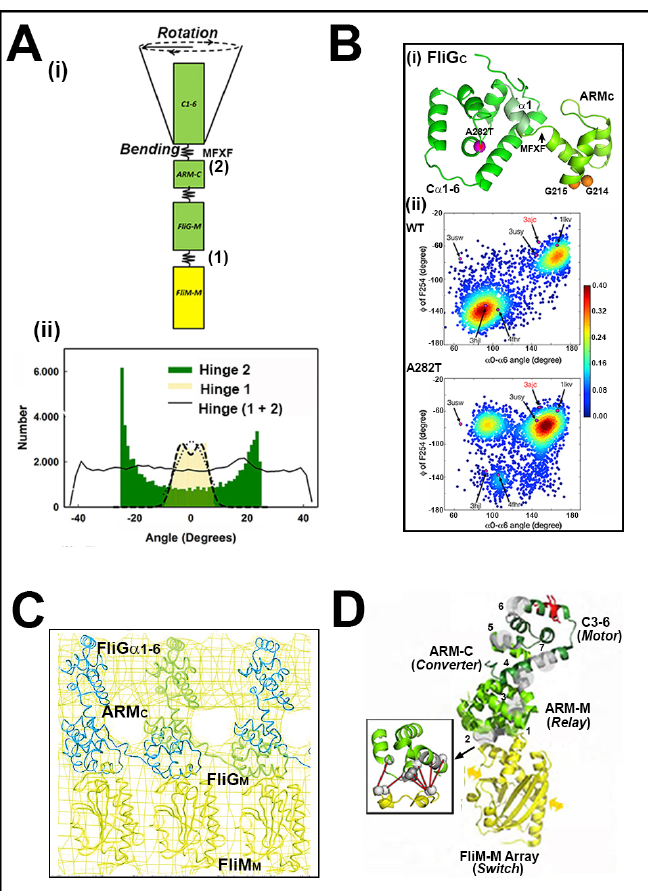
Figure 5. Mechanics of rotation reversal. ( A ) Mechanical amplification: ( i ) The T. maritima FliM M FliG MC crystal structure (PDB: 4fhr. FliM M (gold), FliG MC (green)), modelled as a segmented rod with flexible hinges. Two-stage amplification of FliM M motions triggers large FliG C domain reorientations. ( ii ) Bimodal hinge planar angle distributions from the dominant principal collective motions 1–3 extracted from the generated conformational ensemble. Lines plot the 3D angular displacement distribution (solid) and unimodal fit (dotted). The distribution of the FlIM M FliG M interfacial hinge (1 (gold)) has a narrow spread relative to the MFXF hinge distribution (2 (green)), indicating most of the amplification occurs at the latter hinge (from [81]). ( B ) MFXF hinge dynamics: ( i ) The representative structure of the V. alginolyticus FliGc A282T homology model from cluster analysis of the MD ensemble. The predicted dynamic helix α 1 (pale green), the MFXF 254 motif, and residues G214, G215 (orange) and T282 (magenta with an asterisk) are marked. 2D-NMR reports the CW-biasing A282T residue substitution melts helix α 1 and reorients MFXF 254 . ( ii ) The 2D plot of F254 dihedral angle versus helix α 6 orientation relative to the FliG M. FliG C interface obtained from the MD trajectories. The wild-type (WT) and mutant (A282T) conformational clusters map onto di ff erent subsets of the FliGc crystal structures. Labeled circles (magenta) mark structures from T. maritima (CW-locked. PDB: 3ajc; wild type. PDB: 1lkv; complexed with FliM M (PDB: 4fhr)), Helicobacter pylori (PDB: 3usy and 3usw) and A. aeolicus (full-length. PDB: 3hjl) (from [113] with permission). ( C ) The FliG M -ARMc stacking interaction: The best-fit of the pulsed dipolar ESR spectroscopy model of the T. maritima FliG M -ARMc inter-domain stack to the 3D S. enterica electron density map (from [108] with permission). ( D ) Residue coevolution model for rotation reversal: Strong, coevolved FliM M (yellow) contacts mediate conformational spread (arrows) in the FliM M ring. The FliG α C3-6 “motor domain” (dark green) is organized around the α C5 “torque helix” with charged residues (red) important for rotor–stator interactions. The primary nodes of the coevolved network form a relay of allosteric sectors (numbered grey patches) across